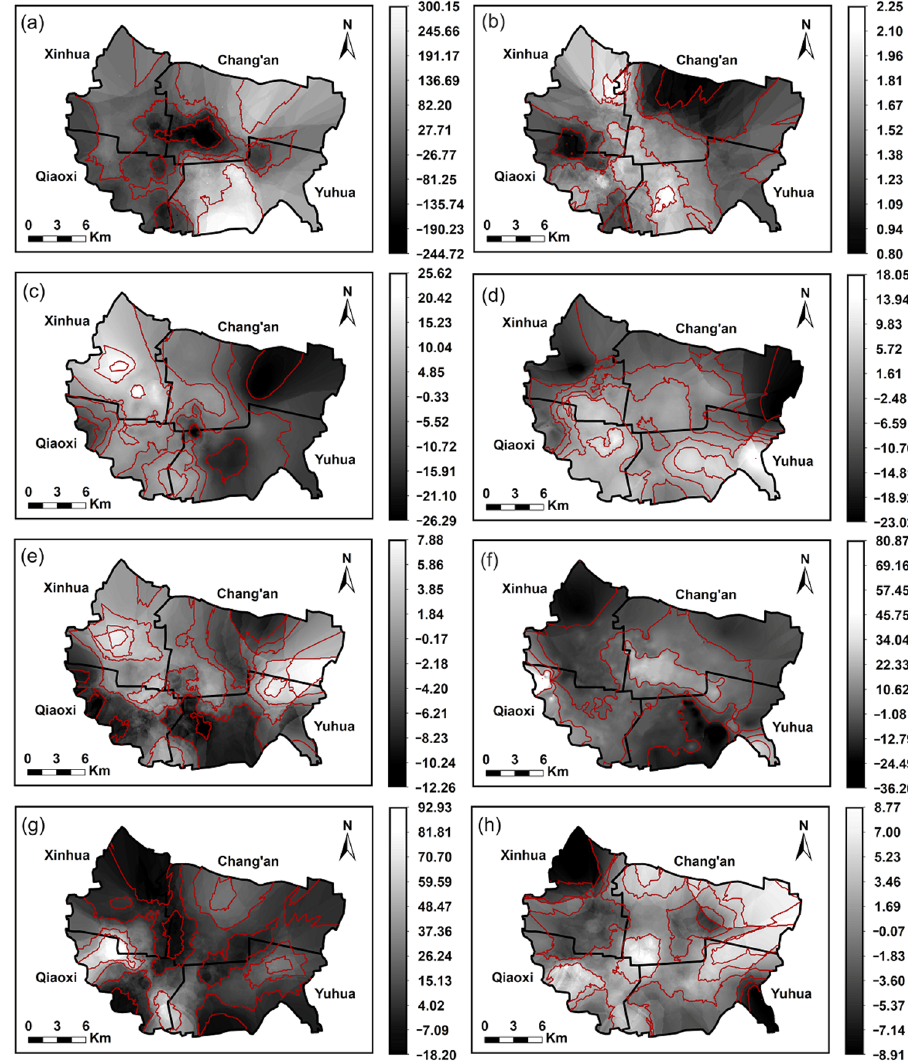
Figure 4. Spatial mapping for: ( a ) coefficients of intercept; ( b ) total floor area; ( c ) proximity of the nearest park; ( d ) proximity of the nearest transport facility; ( e ) proximity of the nearest central shopping plaza; ( f ) proximity of the nearest river; ( g ) total number of bathrooms; ( h ) proximity of the nearest central business district, by contextualized geographically and temporally weighted regression